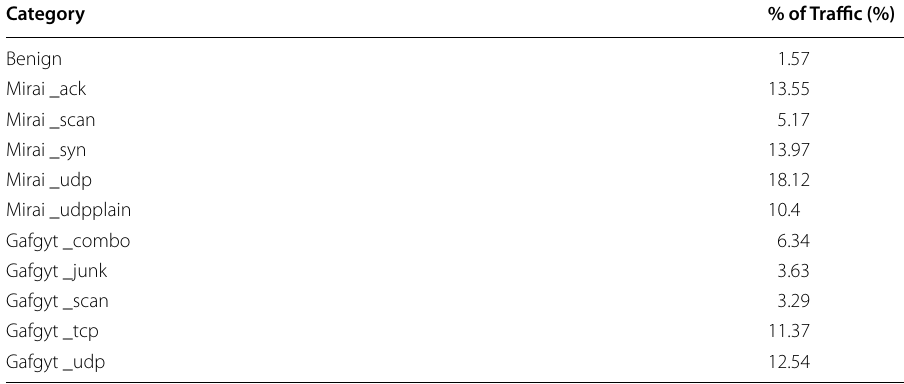
Table 4 % of benign and attack traffic in UNSW-NB17_Ecobee Category